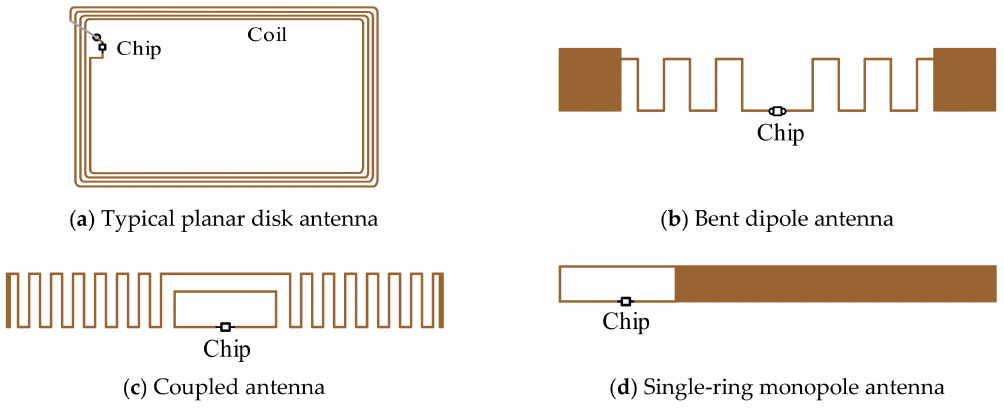
Figure 5. Commonly Used RFID Antennas